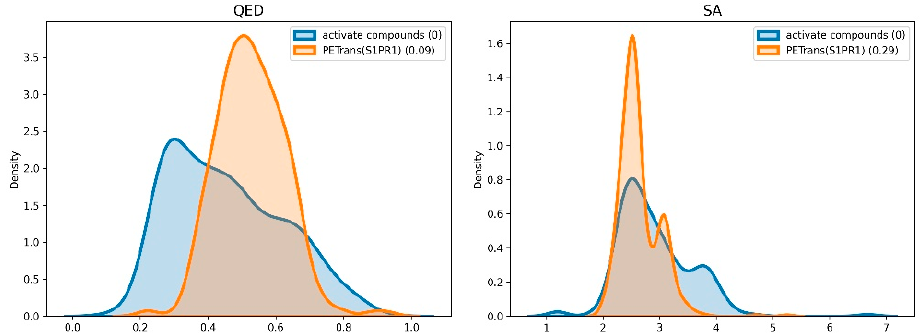
Figure A5. Distributions of the docking scores of the generated molecules for HTR1A.